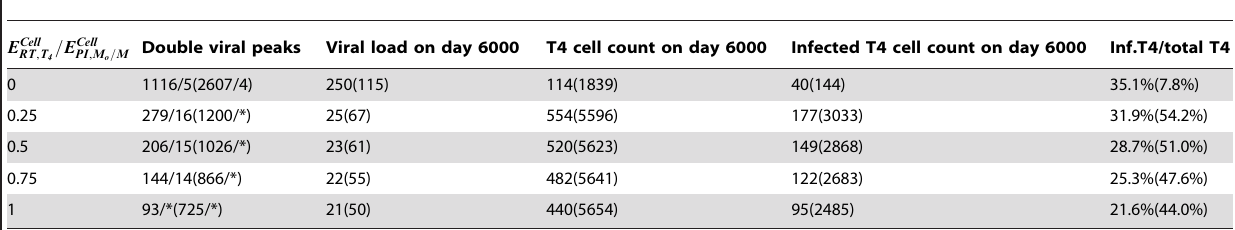
Table 4. Simulation of different levels of drug effectiveness in different cell types.